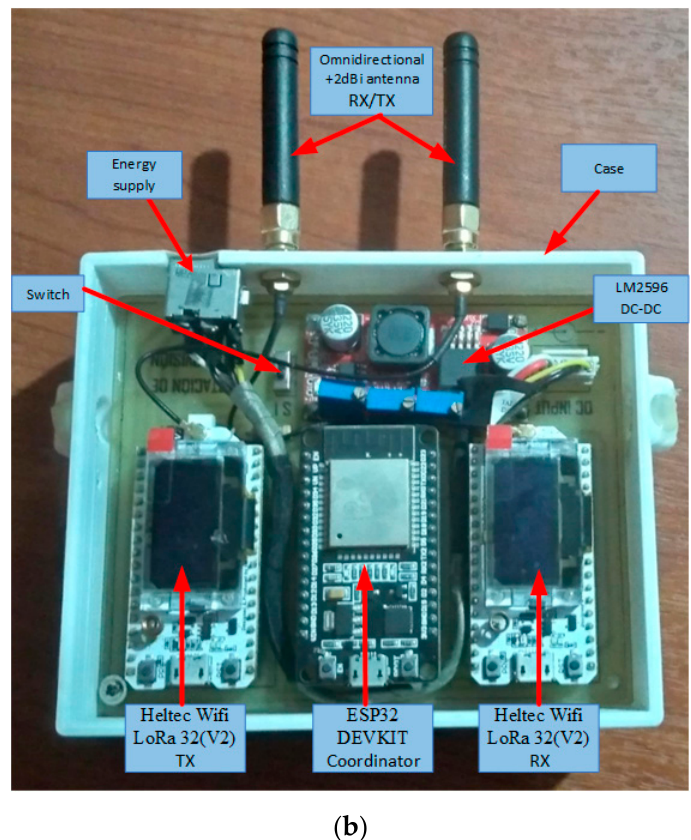
Figure 5. ( a ) Electronic schematic and ( b ) gateway manufacturing.